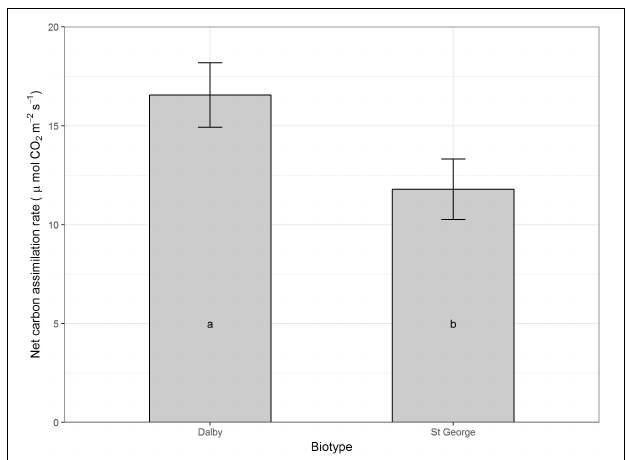
FIGURE 3 | Net carbon assimilation rate ( µ mol CO 2 m - 2 s - 1 ) of rosette leaves of two Australian biotypes (St. George and Dalby) of Sisymbrium thellungii. There were no significant interactions between biotype and water regime so data shown are means for each biotype across all treatments predicted from the linear mixed model. Vertical lines represent standard error and letters within columns indicate whether differences were significant at α = 0.5.